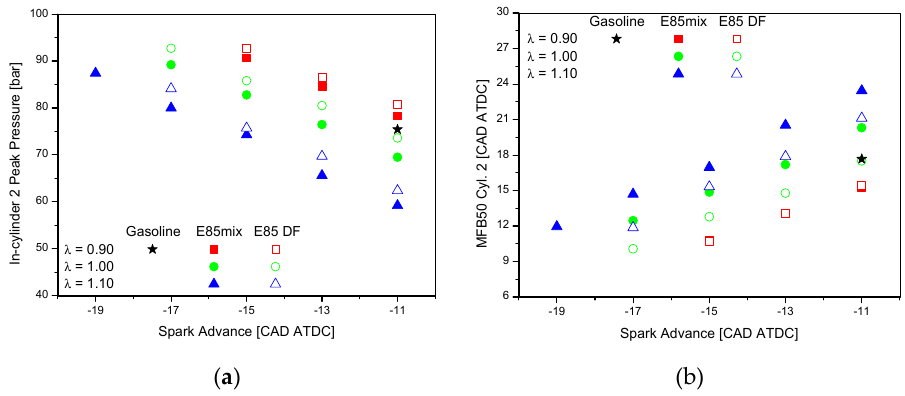
Figure 4. In-cylinder peak pressure profile ( a ) and combustion phasing-MFB50 ( b ) profile against SA at different λ .